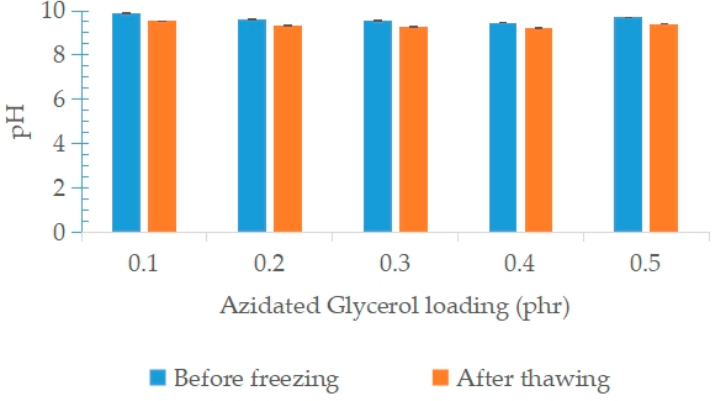
Figure 12. pH of NRL containing variable loadings of AG before freezing and after the freeze–thaw processes.